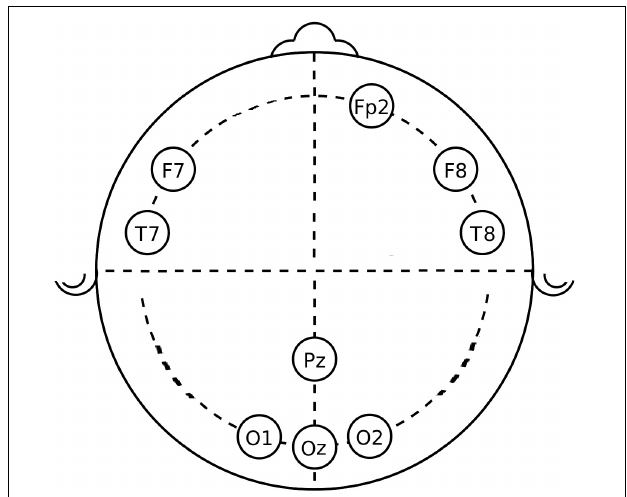
FIGURE 1 | Location of EEG channels recorded. The circles represent the approximate location of the electrode for each channel.